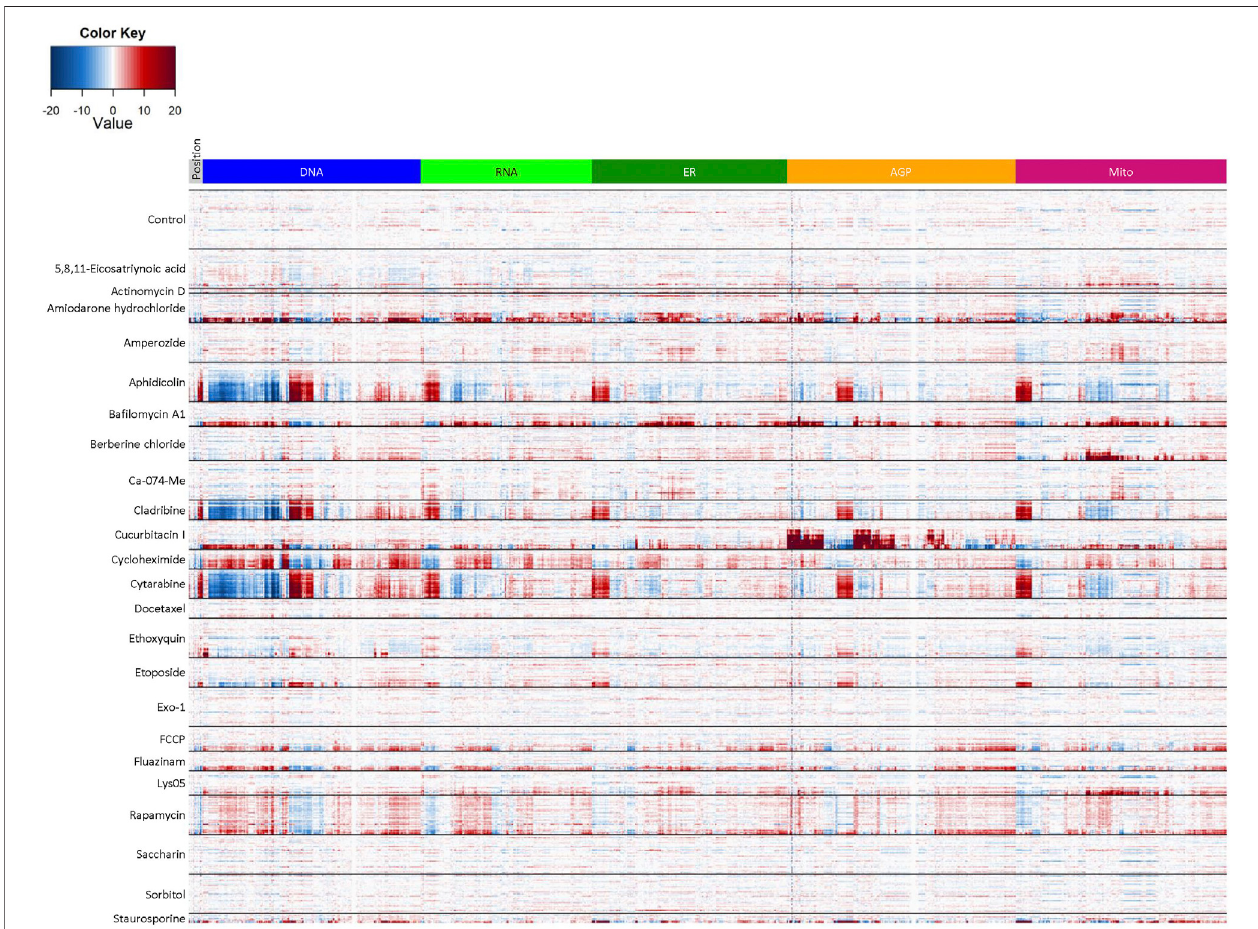
FIGURE6| Referencechemicalsetheatmap.Cell-leveldatawereexportedtogeneratetheheatmapinRstatisticalsoftware.TestconcentrationsabovetheLOEC for each chemical wereremoved prior toanalysis.Datarepresent three biological replicates (i.e., independent cultures) which includes two technical replicates/chemical concentration per biological replicate. The rows in each clade from top to bottom depict the tested concentration range from lowest to highest value (see Table 1 ) and are organized by chemical, whereas the columns depict individual features organized by channel. Heatmap coloring represents the size and direction of the phenotypic effect relative to DMSO vehicle control